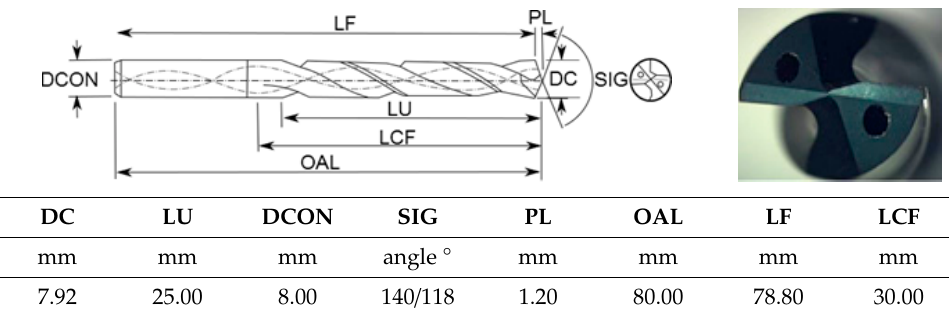
Table 1. Cutting tool geometrical parameters (VUS85CS0377).